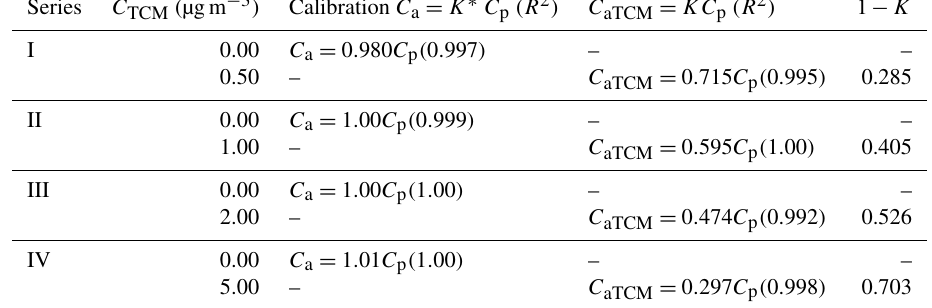
Table 4. Calibration lines of Analyser I obtained by linear regression (without TCM ( C a ) and with TCM ( C aTCM ) ). R 2 is shown in brackets. The parameter 1 − K is also shown.